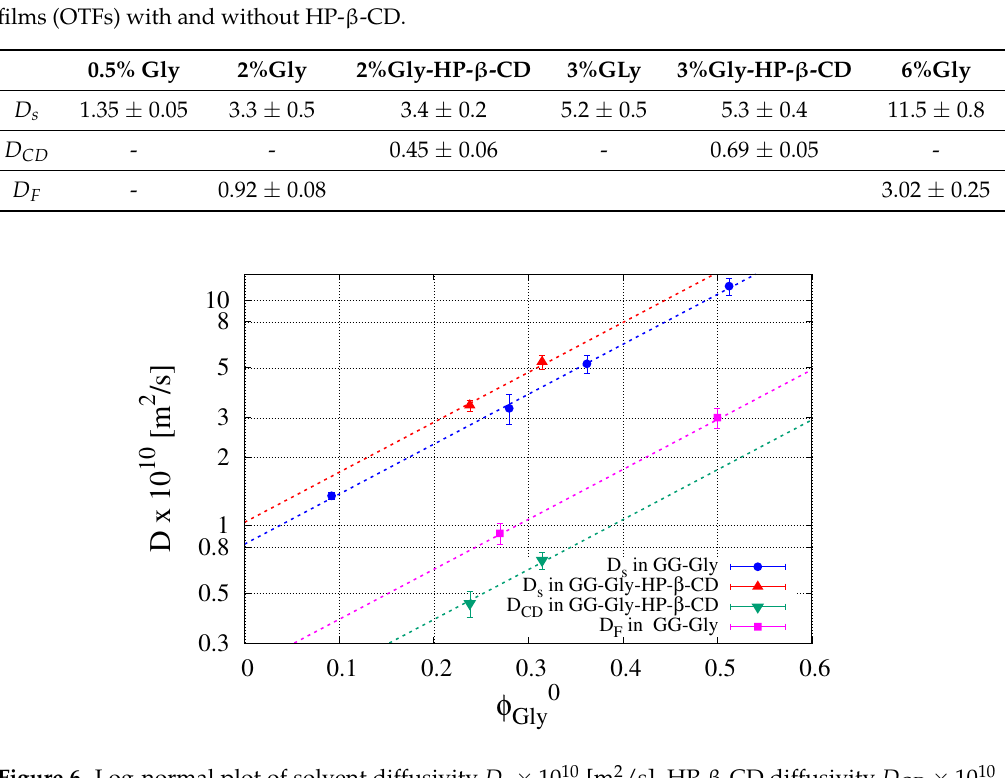
in the dry film. Gly ) Gly